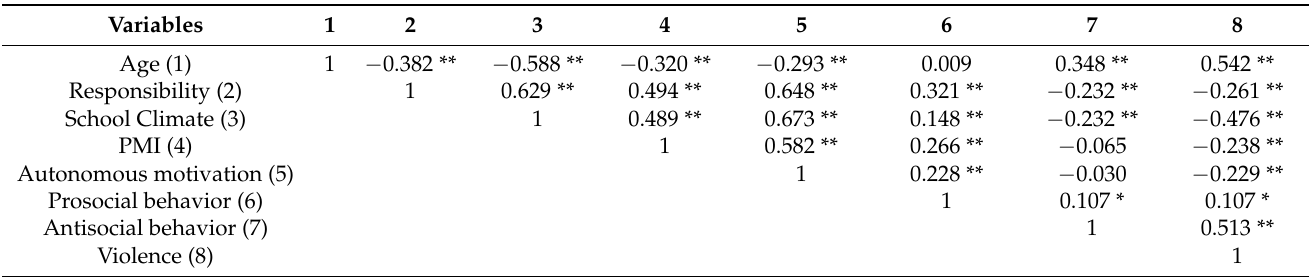
Table 2. Correlations between variables and age.